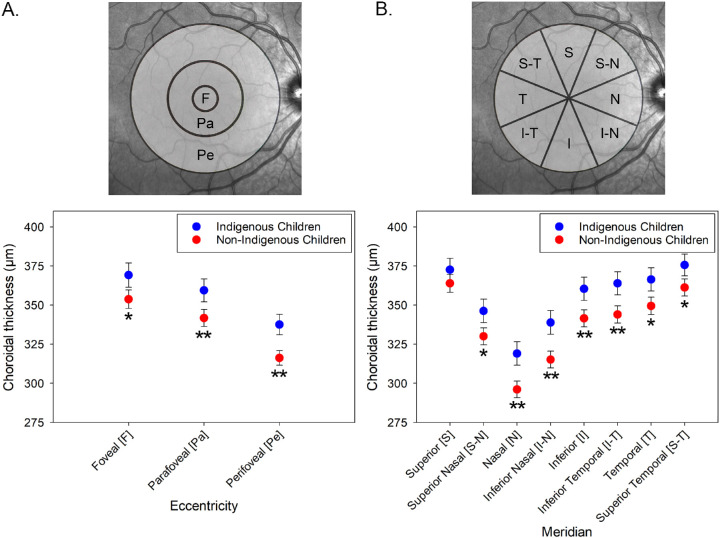
Variations in mean choroidal thickness in Indigenous and Non-Indigenous children over different macular eccentricities (A) and meridians (B). * P < 0.05 and ** P < 0.01 indicate a significant difference between Indigenous and non-Indigenous children. Error bars represent the standard error of the mean.